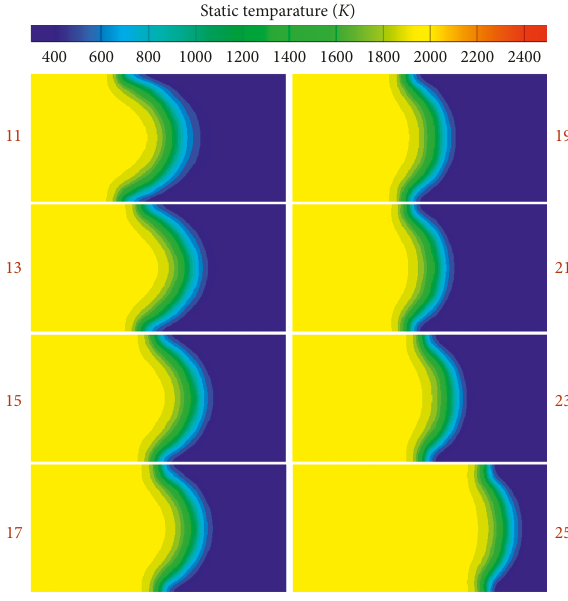
Figure 7: Flame propagation characteristics of deflagration in the subsequent stages.